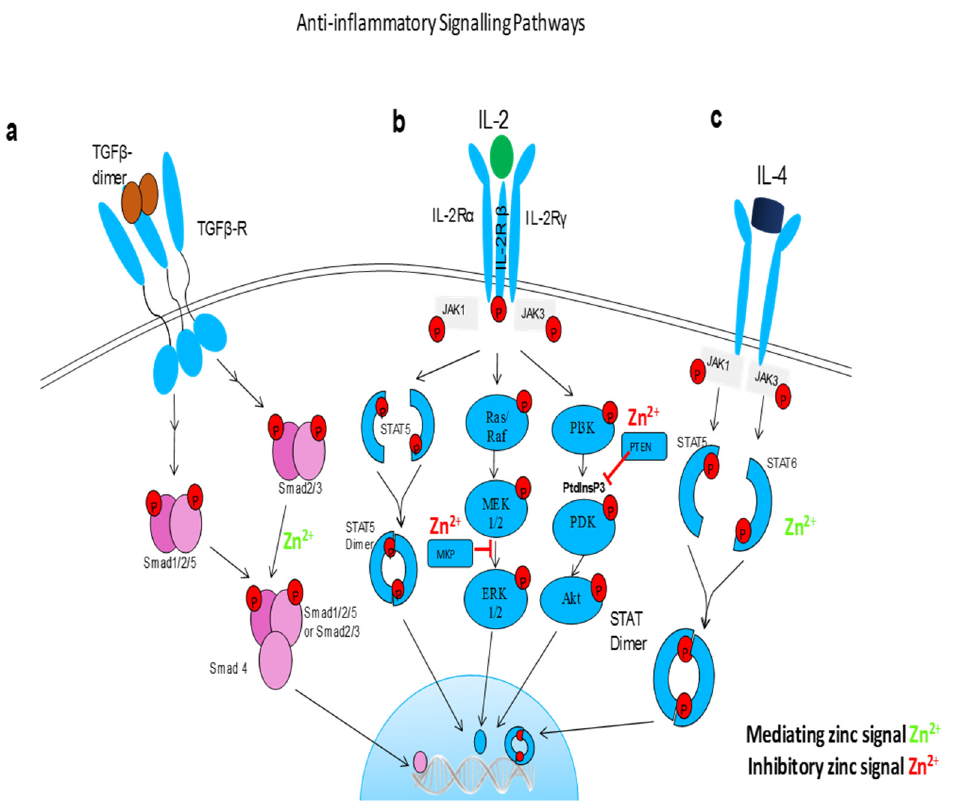
Figure 3. Anti ‐ inflammatory signaling pathways influenced by free zinc. ( a ) TGF β signaling is dependent on a dynamic on and off switch in Smad activity. Free zinc is a cofactor in Smad proteins and promote Smad 2/3 nuclear translocation and transcriptional activity. ( b ) zinc regulates IL ‐ 2 signaling pathway via blocking MAP kinase phosphatase (MKP) in extracellular signal ‐ regulated kinases (ERK) 1/2 pathways and Phosphatase and tensin homologue (PTEN) which opposes phosphoinositide 3 ‐ kinase (PI3K) function in PI3k/Akt pathway. ( c ) free zinc phosphorylates STAT6 and promotes translocation of STAT dimers into the nucleus, hence promote the anti ‐ inflammatory effects of Il ‐ 4.